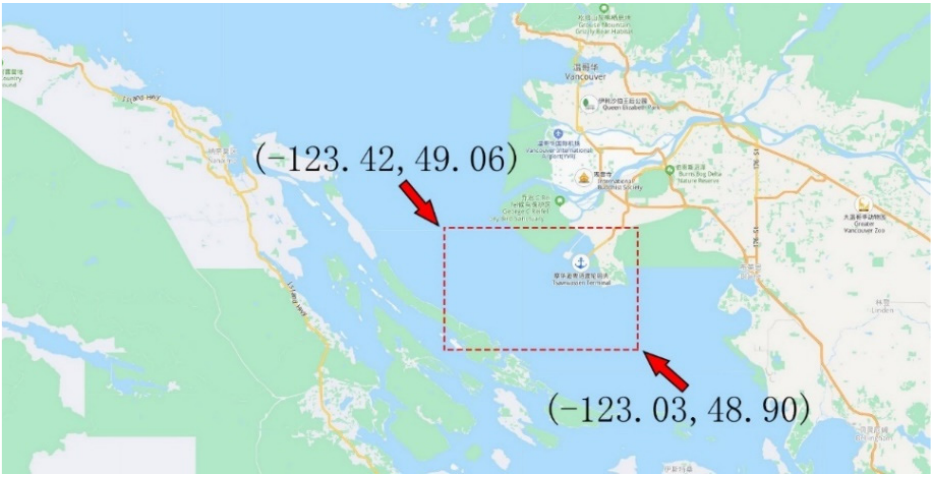
Figure 6. Longitude and latitude information of the water area where the experimental data are located.